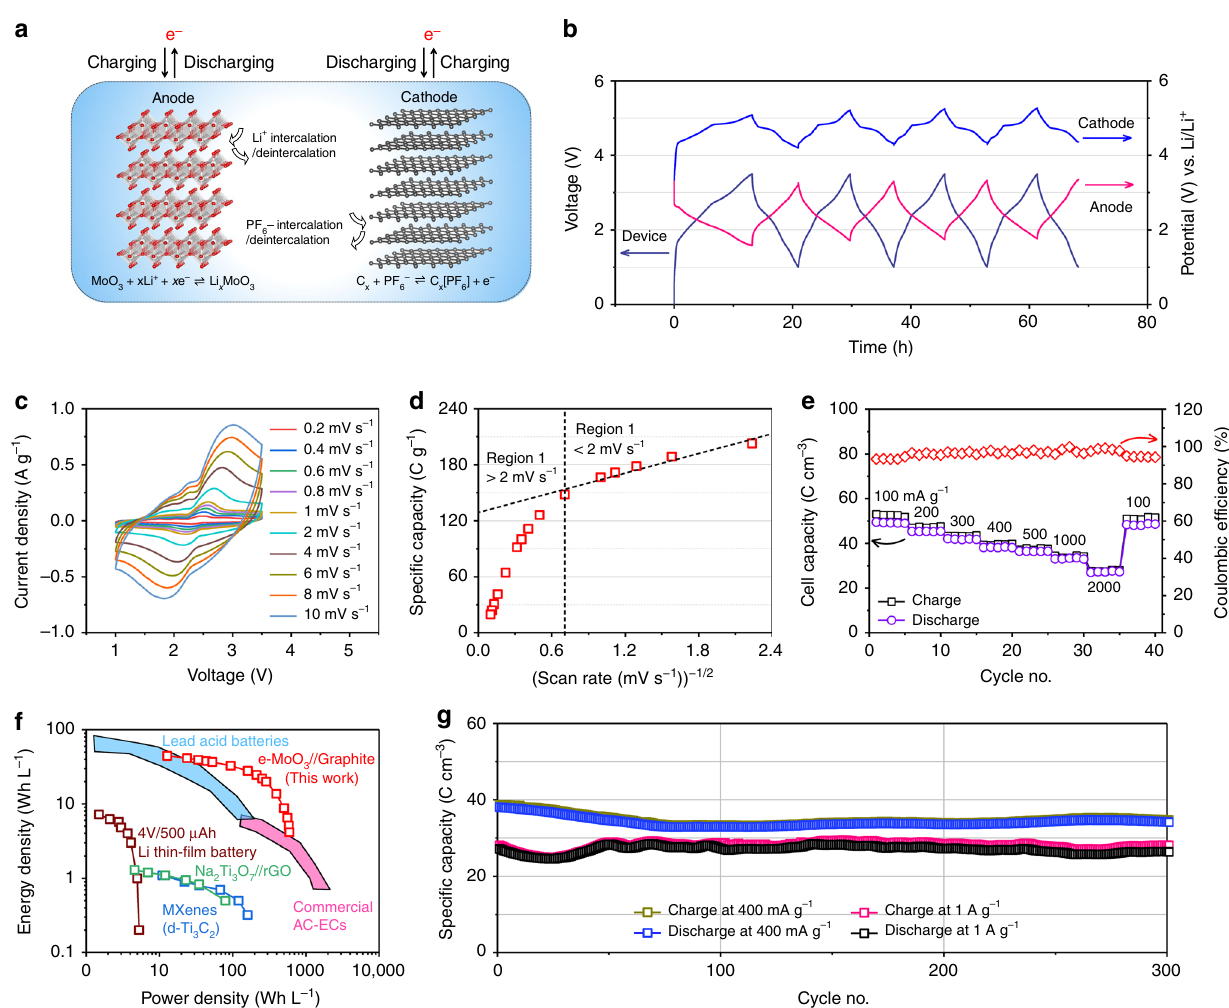
Fig. 4 e-MoO 3 //graphite DIES device. a Design of the dual-ion-intercalation MoO 3 //graphite cell. On the anode side, predominantly Li + is intercalated and de-intercalated between [MoO 6 ] layers of MoO 3 during charge/discharge. On the cathode side, graphite is used as a host for hexa fl uorophosphate (PF 6 − ) anion intercalation/de-intercalation. b The initial four galvanostatic charge/discharge cycles at 100 mA g − 1 and the corresponding potential variation of the cathode and anode. c CV curves of the device at different scan rates. d Change of the gravimetric capacity based on the total active mass as a function of v − 1/2 . e Rate performance of the e-MoO 3 //graphite device based on the volume of the whole device. f Ragone plots of e-MoO 3 //graphite device in comparison with state-of-the-art electrochemical energy storage devices; the performance is normalized to the total cell volume, which includes the active materials, current collectors and separators. g Cycling performance of the e-MoO 3 //graphite device at 400 mA g − 1 and 1 A g − 1